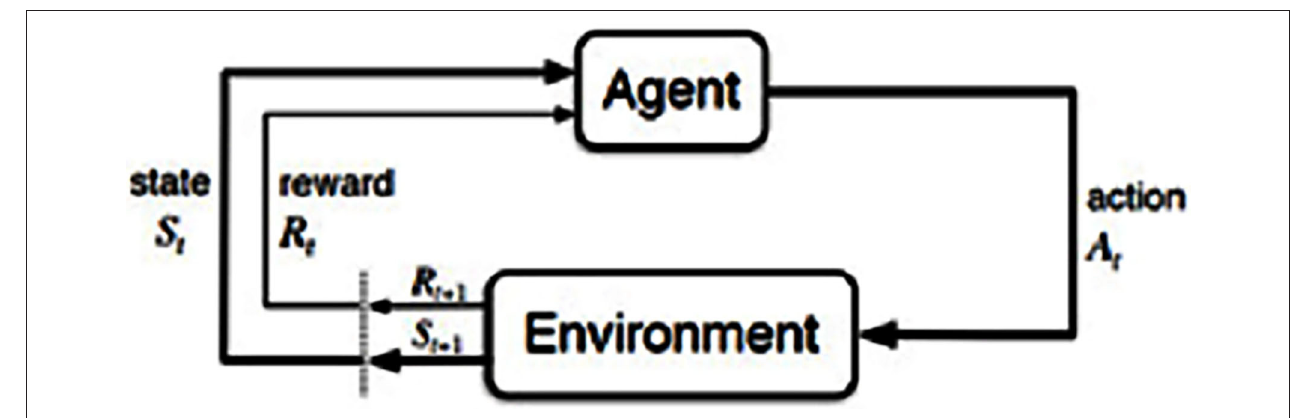
FIGURE 2 | Interaction process of reinforcement